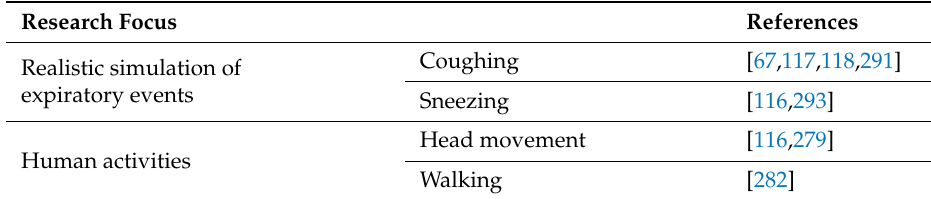
Table 5. Past research using modeling and other simulation approaches to link human behavior, face mask filtration mechanisms and efficiency, and environmental